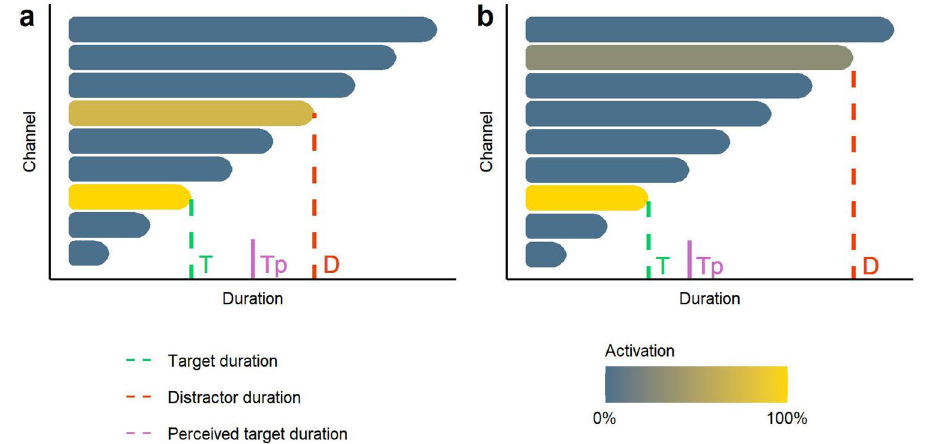
Figure 1. Illustration of the duration-channels activation process. When a target (T) is presented with a distractor (D), both activate the channels associated with their respective durations. The perceived duration of the target (Tp) is shifted towards the duration of the distractor. This information leaking has a stronger effect when distractor and target durations are more similar ( a ) and decays when they are more different ( b